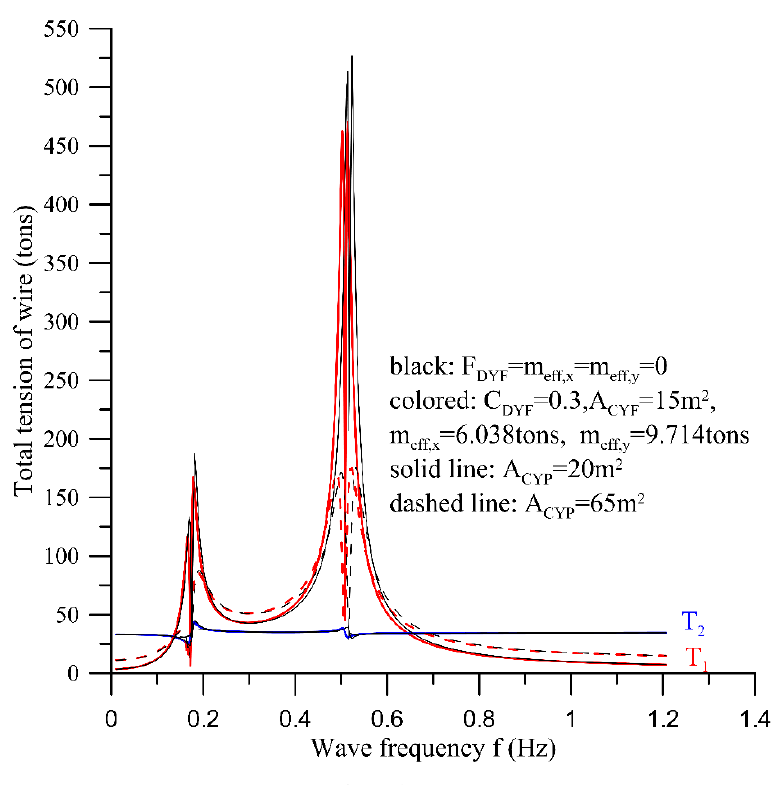
( e ) spectrum of total tension Figure 3. Effects of the cross-sectional area of the towed parachute, Figure 3. Effects of the cross-sectional area of the towed parachute, A CYP and the wave frequency on the dynamic response of the system including ( a ) dynamic displacements f on the dynamic response of the system including ( a ) dynamic displacements { x 1 d , x 2 d , y 1 d } , ( b ) mode shape 1, ( c ) mode shape 2, ( d ) dynamic tensions of rope { T 1 d , T 2 d } , ( e ) total tensions mode shape 1, ( c ) mode shape 2, ( d ) dynamic tensions of rope of rope { T 1 , T 2 } . [ A BB = 3 m 2 , A CYF = 15 m 2 , C DYF = 0.3, C DYP = 1.28, E 1 = E 2 = 100